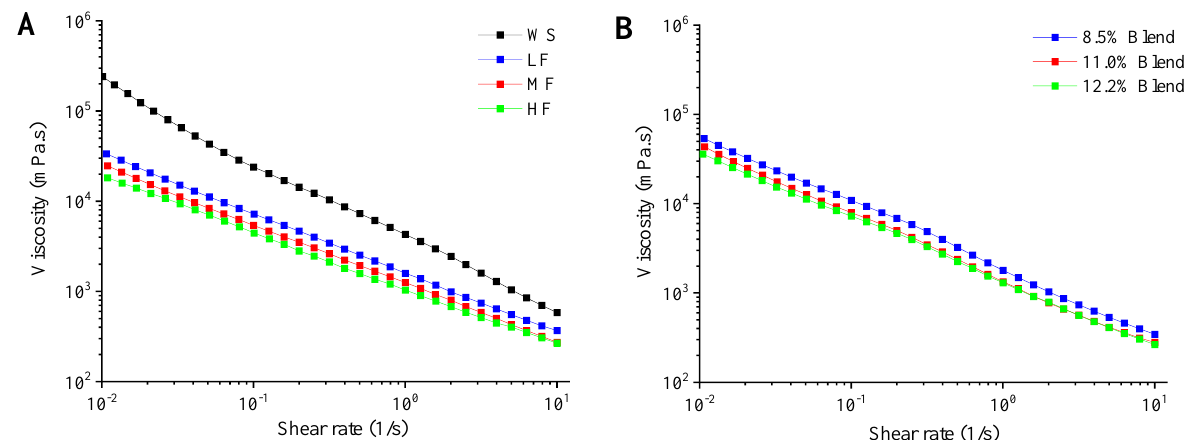
Figure 2. Viscosity as a function of shear rate for the film-forming matrices at 25 °C: ( A ) pure WS, wheat flours with different gluten contents (8.5%, 11.0%, and 12.2%), and ( B ) WS–gluten blends with different gluten contents (8.5%, 11.0%, and 12.2%). Low-gluten wheat flour, LF; medium-gluten wheat flour, MF; high-gluten wheat flour, HF; WS–gluten blend with 8.5% gluten content, 8.5% blend; WS–gluten blend with 11.0% gluten content, 11.0% blend; WS–gluten blend with 12.2% gluten content, 12.2% blend.